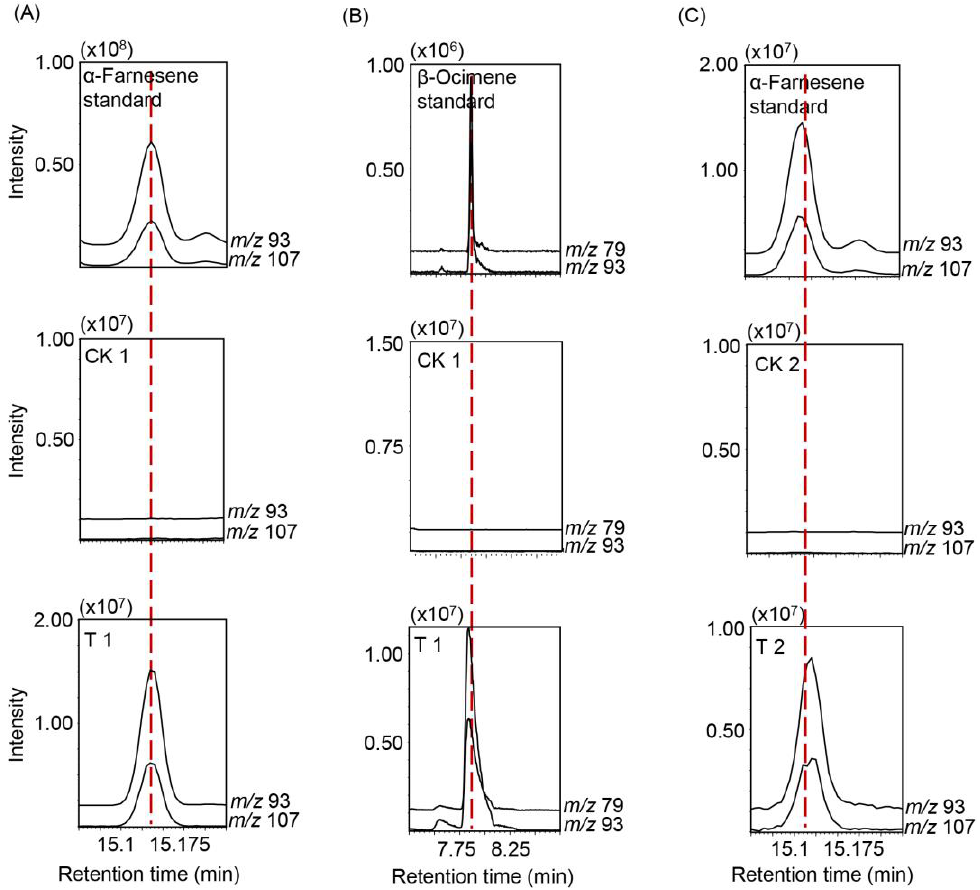
Figure 3. GC-MS analysis of the products formed by recombinant CsAFS enzyme in vitro and in vivo . ( A ) Functional identification of CsAFS in vitro with farnesyl diphosphate (FPP) as substrates; ( B ) Functional identification of CsAFS in vitro with GPP as substrates. CK 1, empty pET32a vector; T 1, recombinant CsAFS-pET32a protein. ( C ) Functional identification of CsAFS in vivo . The CsAFS-green fluorescent protein (GFP) fusion protein was transiently expressed in N. benthamiana. CK 2, empty GFP vector; T 2, recombinant CsAFS-GFP protein.